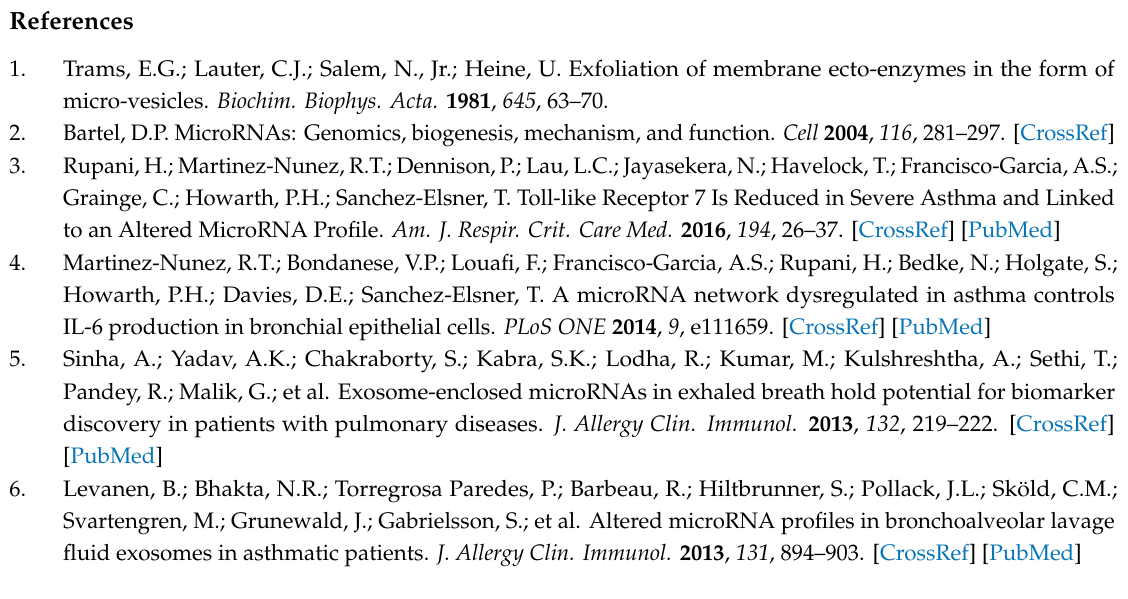
Figure S1: Characterisation of exosomes, Figure S2: RNA quality control of the samples, Figure S3: Correlations of microRNA and clinical parameters, Table S1: 90 microRNAs are downregulated in severe asthmatic BAL exosomal microRNA, Table S2: Pathways dysregulated in